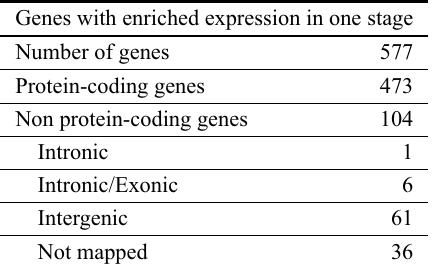
Number of genes with enriched expression in one developmental stage (Bonferroni adjusted p-value <